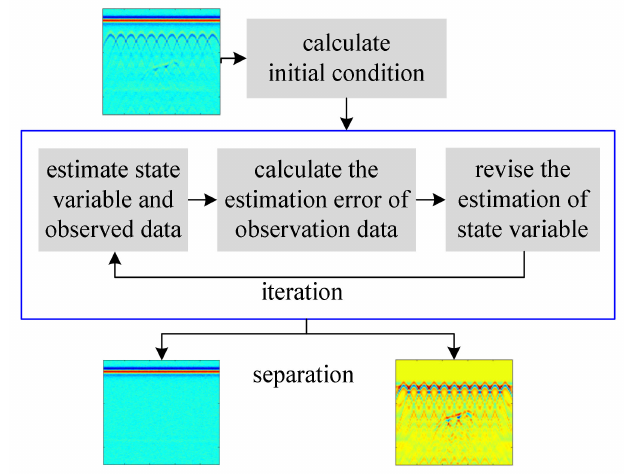
Figure 2. Processing chain for the Kalman filtering under hypothesis H 0